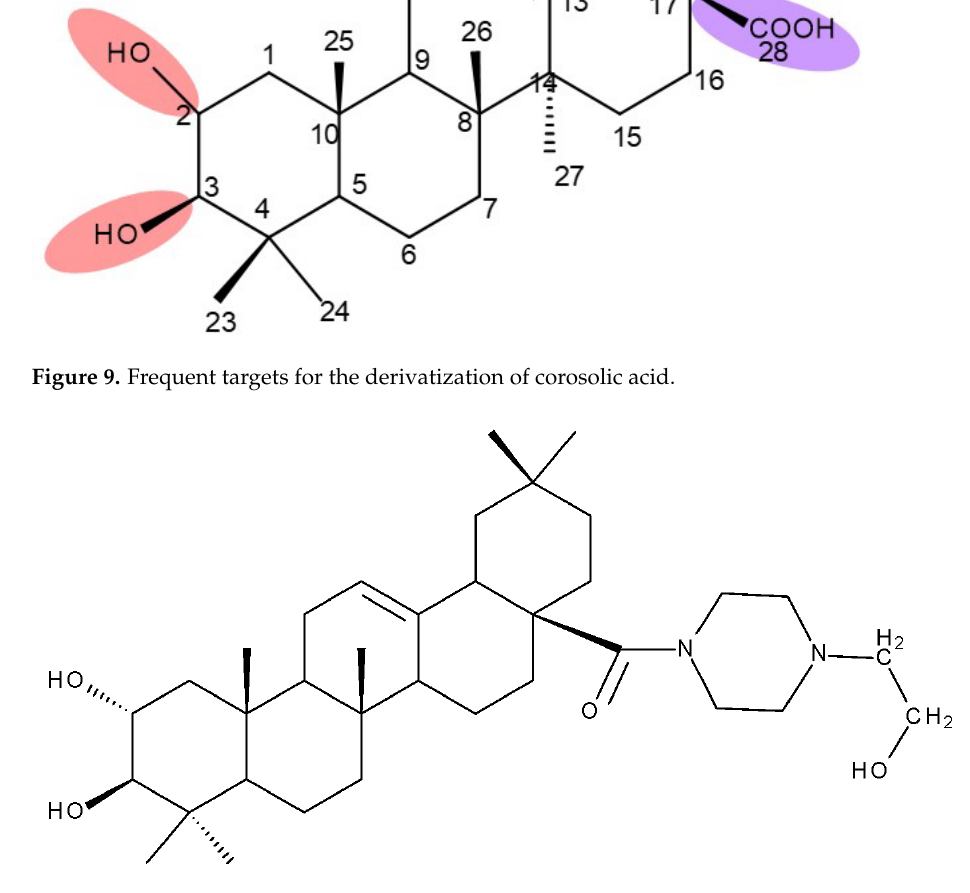
Figure 10. The chemical structure of MA 1.